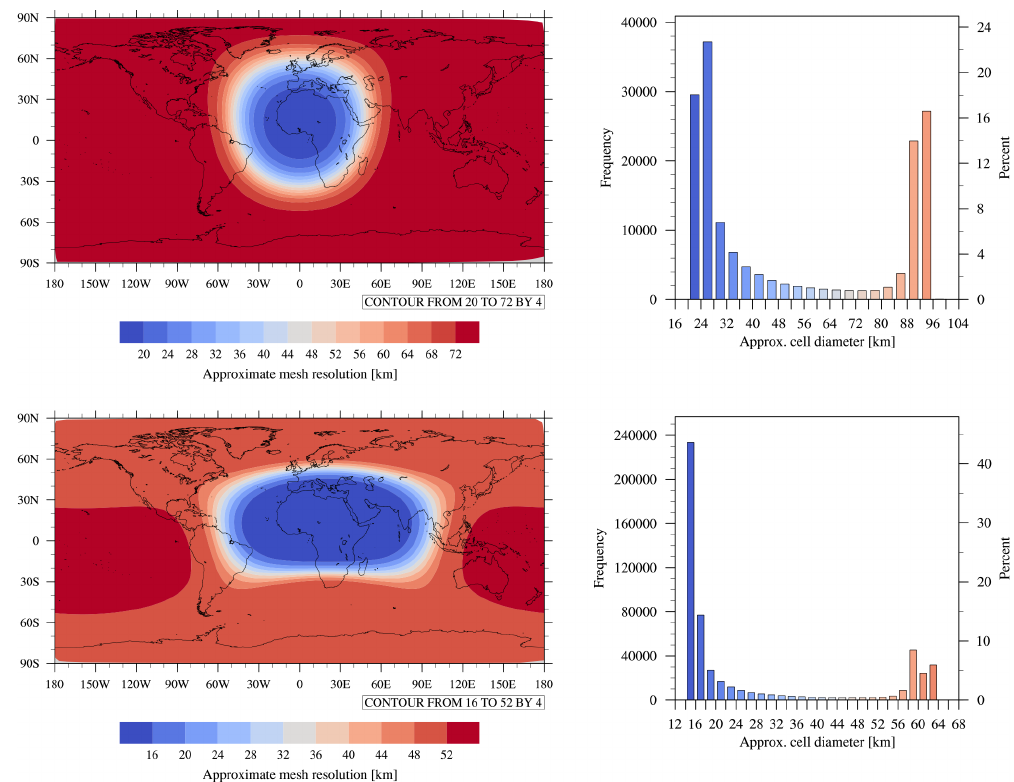
Figure 4. (Left) approximate mesh cell sizes and (right) distribution of mesh cell sizes for (top) the variable 100–25km mesh with 163842 grid cells and (bottom) the variable 60–12km mesh with 535554 grid